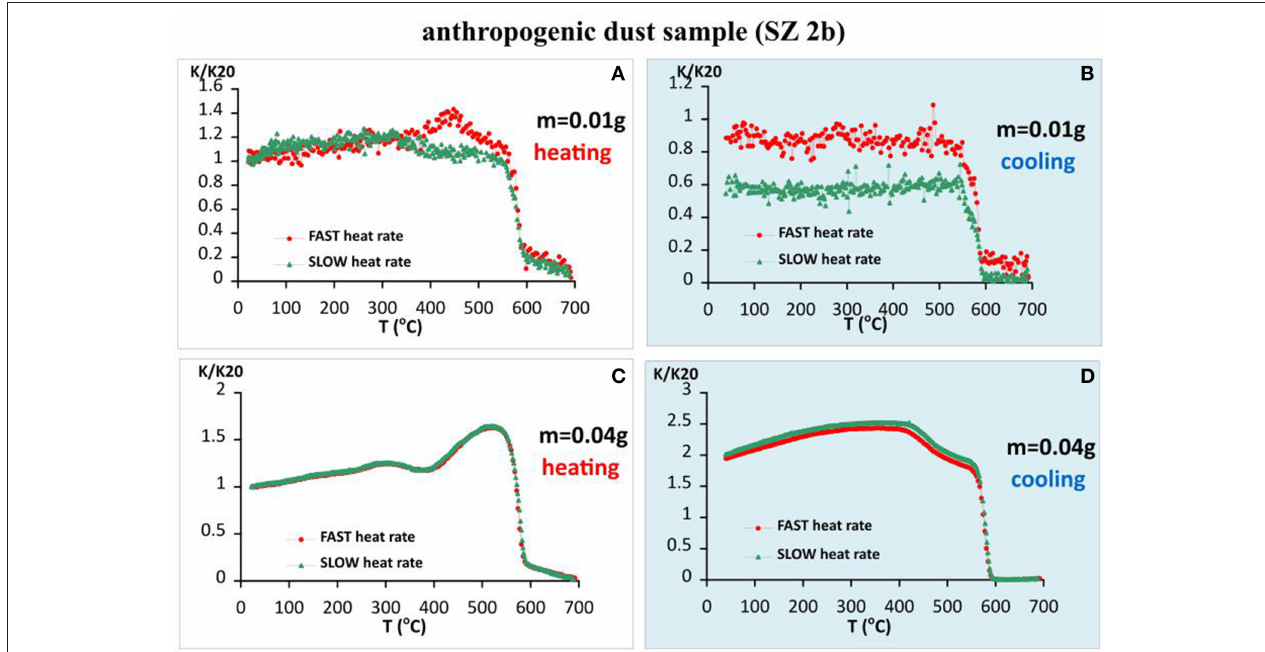
FIGURE 8 | Thermomagnetic analysis of magnetic susceptibility for anthropogenic dust sample SZ 2b, heating in air. (A) Heating curves using fast and slow heating rates for small sample size ( m = 0.01g); (B) cooling curves using fast and slow heating rates for small sample size; (C) heating curves using fast and slow heating rates for large sample size ( m = 0.04g); (D) cooling curves using fast and slow heating rates for large sample size.